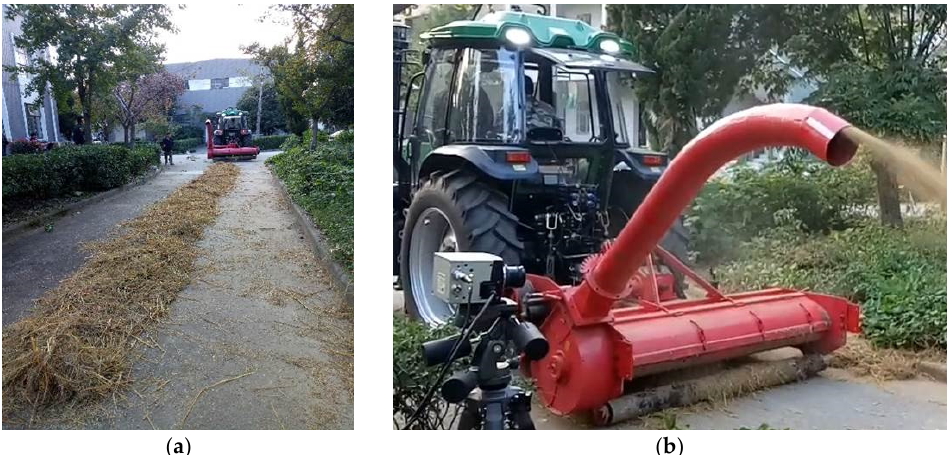
Figure 11. The scenario of verification test: ( a ) the simulative residual straw; ( b ) the operation process of back-throwing device.